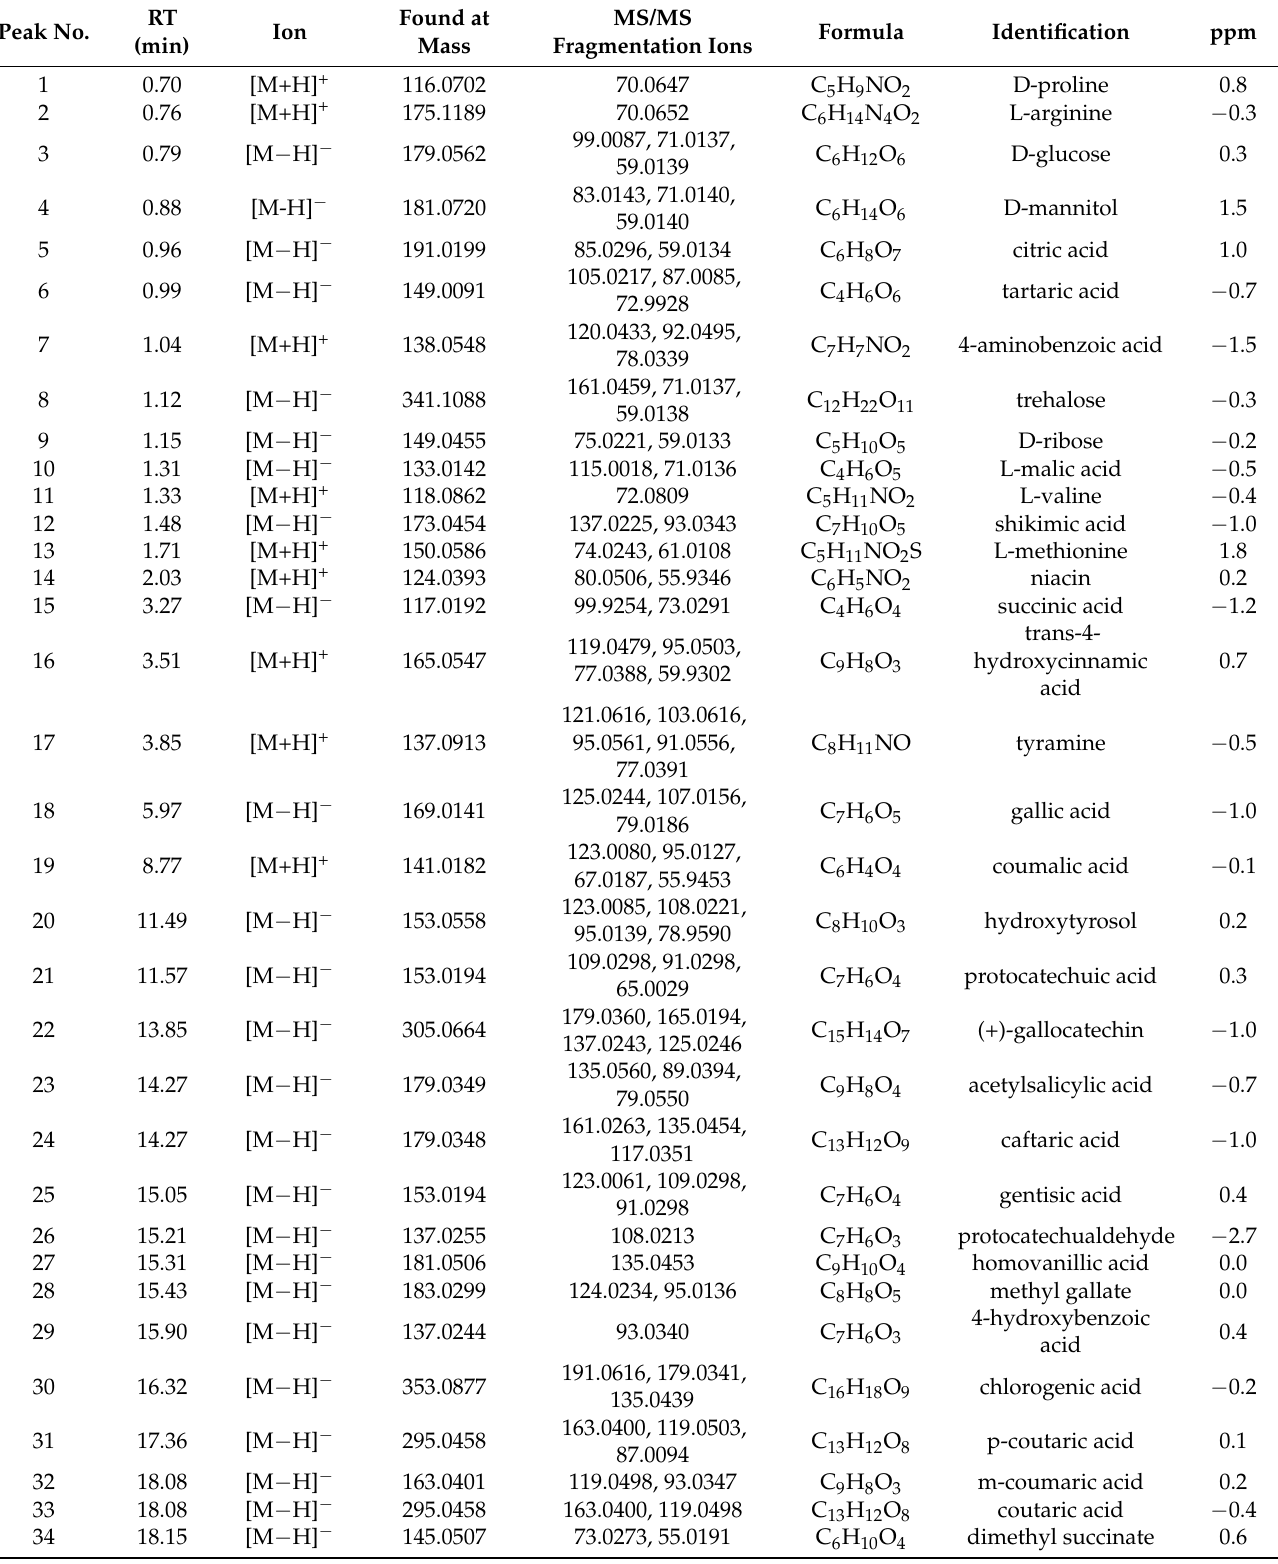
Table 2. UFLC/Q-TOF-MS data and identification 94 compounds from red